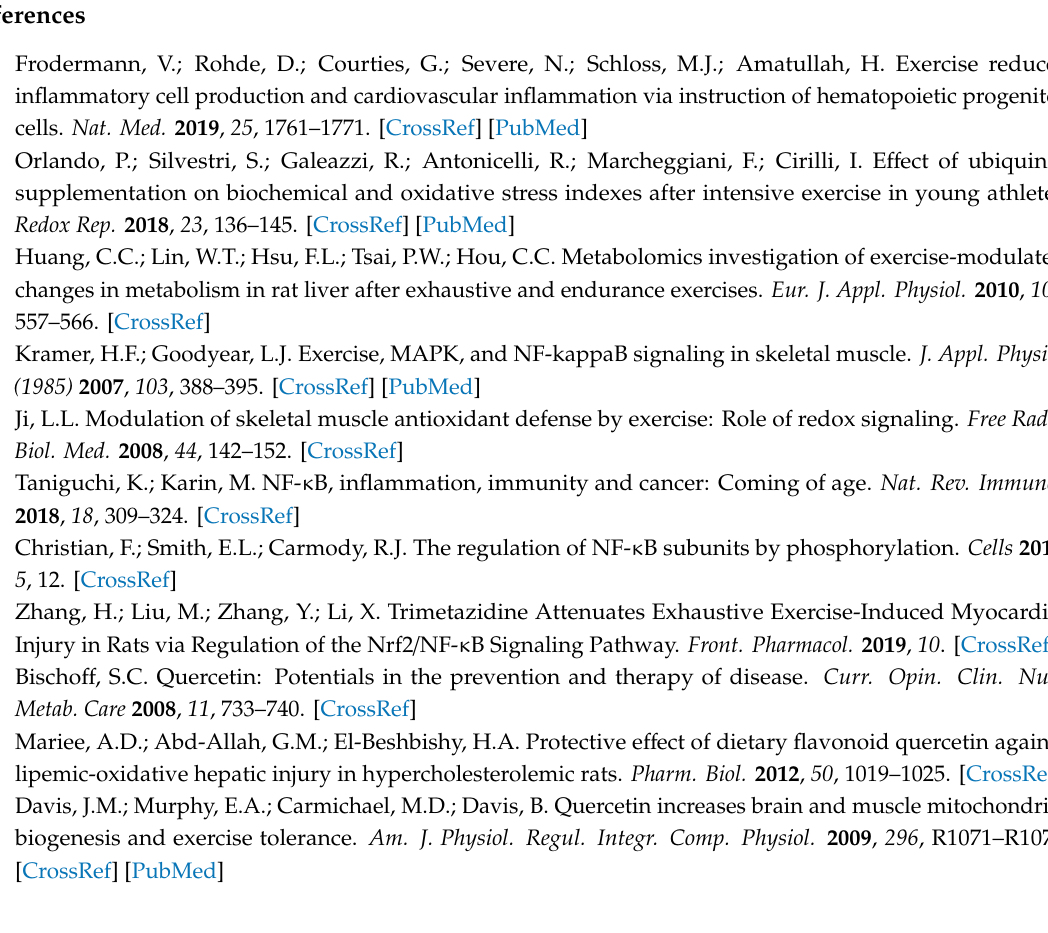
Figure S1: Flow chart of the experiment design, Video S1: Ct—rested control: three-dimensional spatial structure of NF- κ B nuclear translocation in a single mouse hepatocyte, Video S2: Ex—intensive exercise: three-dimensional spatial structure of NF- κ B nuclear translocation in a single mouse hepatocyte, Video S3: Ex + Qu—Ex + quercetin: three-dimensional spatial structure of NF- κ B nuclear translocation in a single mouse